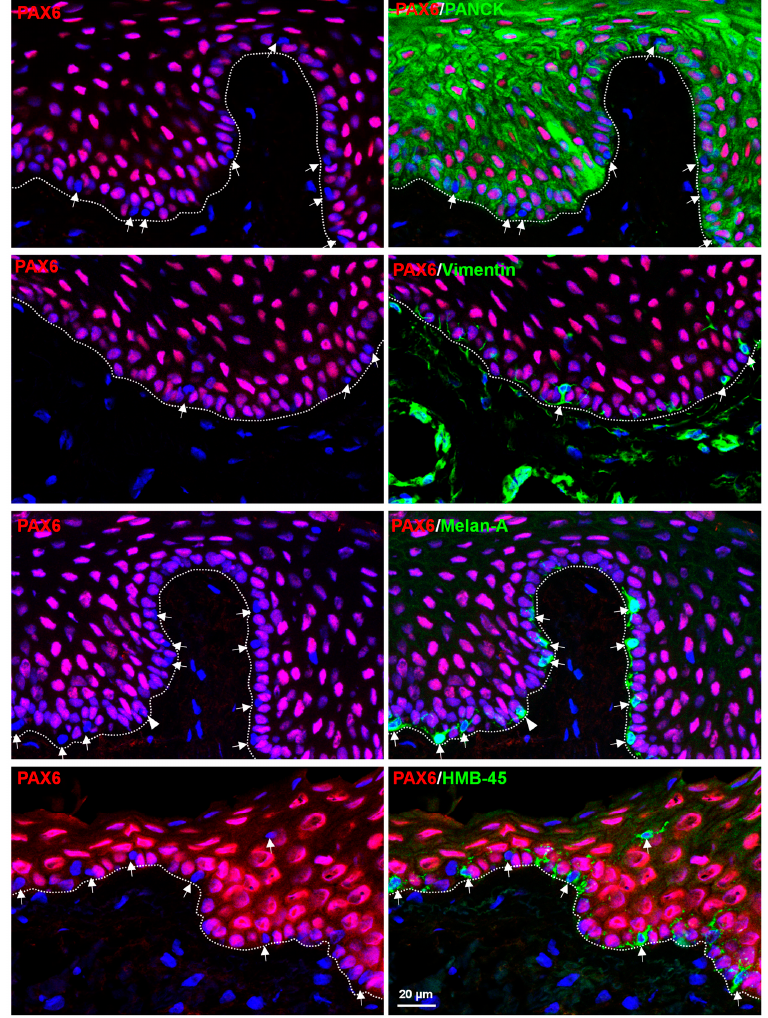
Figure 2. In situ co-localization of PAX6-Double immunostaining of corneoscleral sections showing PAX6-negative cells (arrows) not expressing epithelial keratins (Pan-CK, green) but expressing vimentin (arrow, green) and melanocyte markers Melan-A (green) and human melanoma black − 45 (HMB − 45, green) at the basal layer of limbal epithelium (dashed line represents basement membrane). Images of immunostaining also demonstrate that PAX6 was not expressed in the limbal stroma (vimentin-positive cells, green). PAX6 expression appeared to be present in one of the Melan-A positive cells (arrowhead, Figure 1), but this is due to a superimposed non-melanocytic cell, as revealed in the sequence of the confocal Z-stack images (see Supplementary Information for planes of Z-stack image). Nuclear counterstaining with DAPI (blue). Table 1. List of PAX6-positive and negative